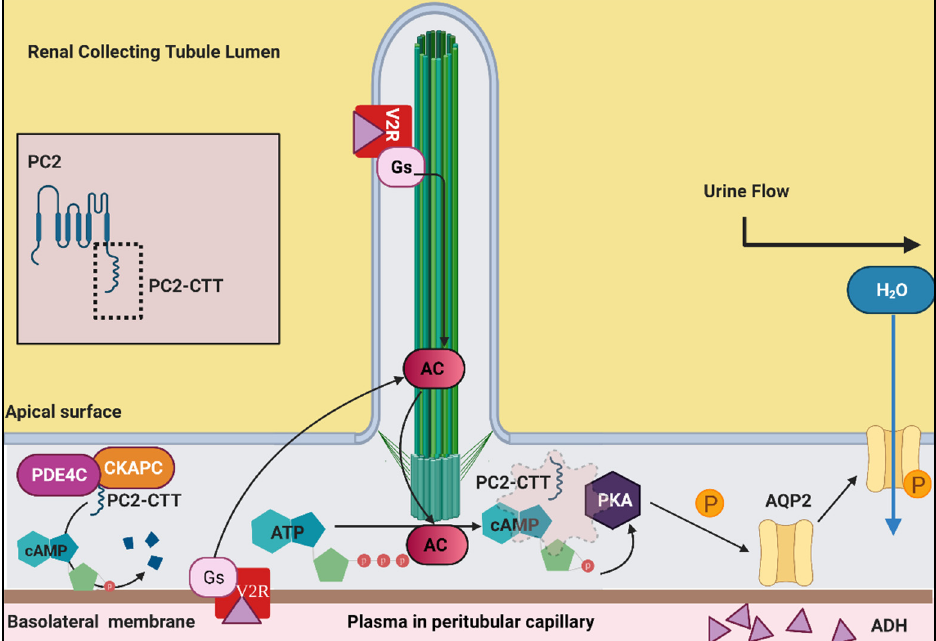
Figure 4. Vasopressin, cAMP and Ca2+ signalling in renal cilium: Vasopressin/ antidiuretic hormone (ADH) is released by the hypothalamus upon sensing hyperosmolar states to facilitate reabsorption of water to maintain homeostasis. Circulating ADH binds to the vasopressin type-2 receptor (V2R) in the kidney which activates adenyl cyclase (AC). AC converts ATP to cAMP which in turn triggers protein kinase A (PKA). The PC2 C-terminal tail (CTT) plays a pivotal role in providing a scaffold for these protein interactions. PKA phosphorylates aquaporin-2 (AQP2) which is then trafficked to the apical surface (towards the tubular lumen), which allows water absorption from urine. The PC2-CTT also interacts with phosphodiesterase 4C (PDE4C) and other components of a ciliary A-kinase anchoring protein complex (CKAPC) [composed of adenylyl cyclase 5/6 (AC5/6), A-kinase anchoring protein 150 (AKAP150), and PKA] and facilitates cAMP catabolism. (Modified and redrawn using BioRender.com [150,179] ).